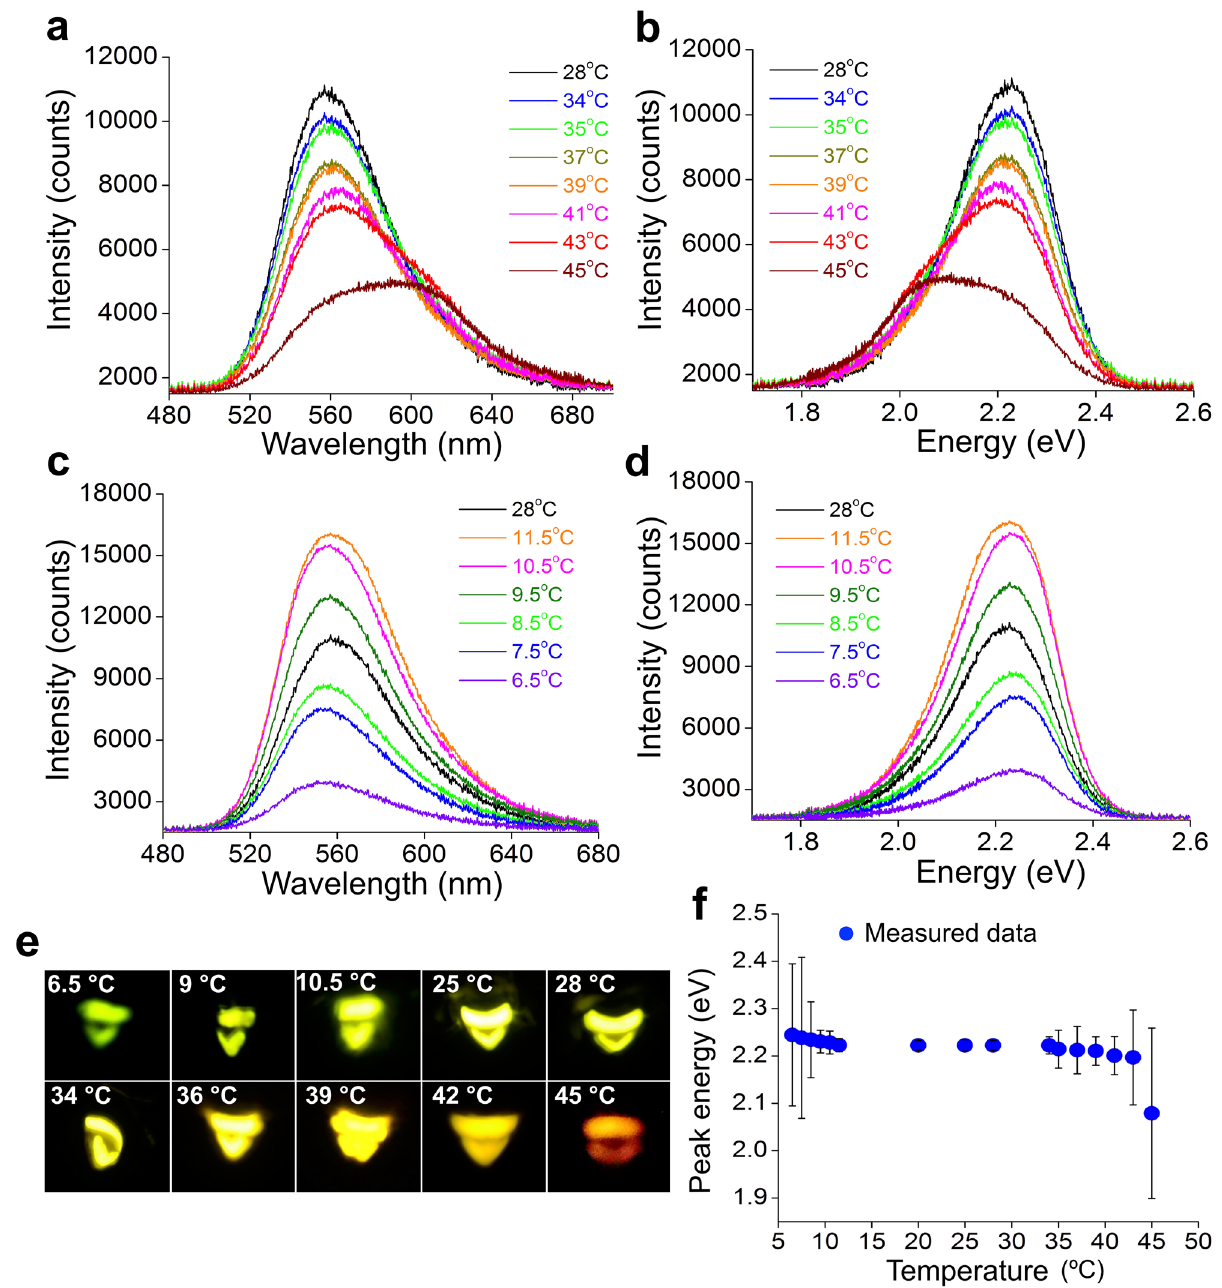
Figure 2. Steady-state emissions from the firefly Sclerotia substriata . ( a , c ) Bioluminescence spectra in the wavelength scale. At the normal laboratory temperature of 28 ºC, the peak of the spectrum appears at 558 nm with a FWHM value of 61 nm. Values of the peak and the FWHM remain the same up to 34 ºC. As the temperature is gradually increased further, the peak of the spectrum begins to shift towards red and the FWHM begins to get broadened with its lower and upper points also showing red shifts. At 45 ºC, the peak shifts to a maximum value of approximately 598 nm, and the FWHM extends to a maximum value of approximately 96 nm. At low temperatures, values of the peak and FWHM remain the same up to approximately 10.5 °C. Thereafter, the peak shifts towards blue and the FWHM gets narrower. At 6.5 °C, the peak shifts to 553 nm and the FWHM gets narrowed to the value of 57 nm. ( b , d ) Bioluminescence spectra in the energy scale. The bioluminescence peak energy, which remains the same up to 34 ºC, decreases slowly up to 41 ºC and thereafter rapidly up to 45 °C. ( e ) Photographs of the firefly light emitting organ at various temperatures. There is no change in the color of the light organ at 25, 28, and 34 ºC, which indicates the same values of peak and FWHM. The color changes to yellow at 36 ºC, to yellow-orange at 39 and 42 ºC, and to red at 45 ºC. On the other hand, the lantern shows tinges of green at 10.5 and 9 °C; the color becomes predominantly green at 6.5 ºC. This figure is a visual indication of shifts in the wavelength peak. Changes in the color from yellowish-green to red and to green make it clear that the peak gets shifted at both high and low temperatures. ( f ) Measured peak energy data (mean ± SD) at various temperatures in the range of 6.5–45 ºC. Standard deviations, that is, fluctuations, are clearly much more at both low and high temperatures compared to those at normal